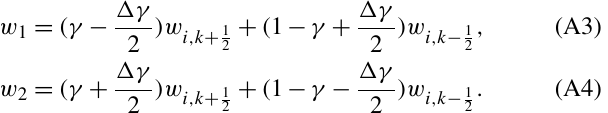
Figure A1. Interpolation of particle-advecting velocities from the grid cell (large rectangle) into a subgrid-scale volume (small rect- angle) applying the simple interpolation scheme (Fig.